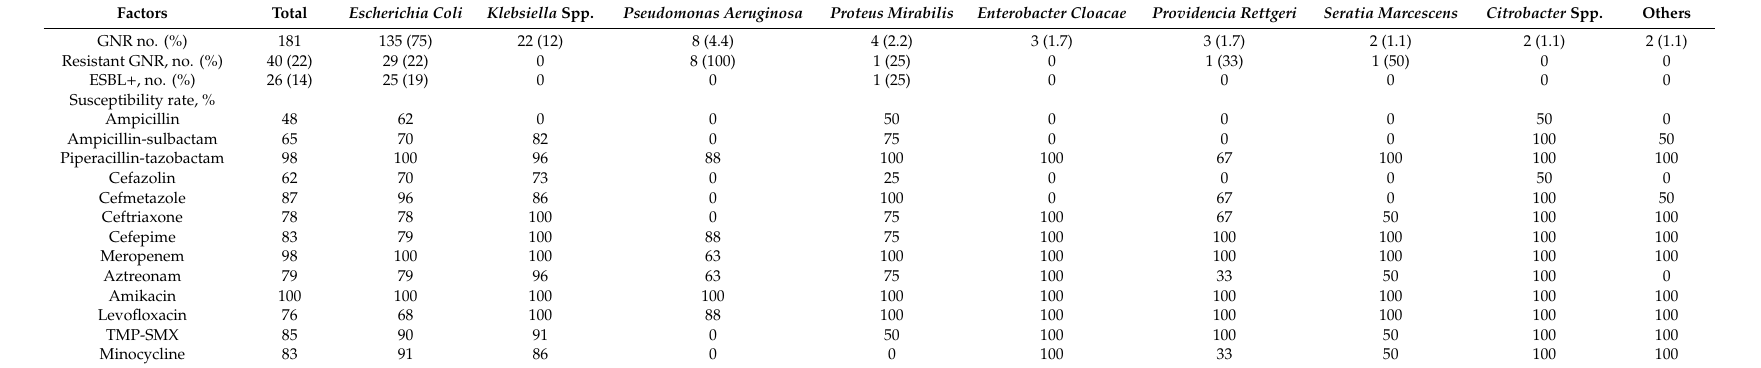
Table 2. Gram-negative rods causing urinary tract infection and their antimicrobial resistance pattern.